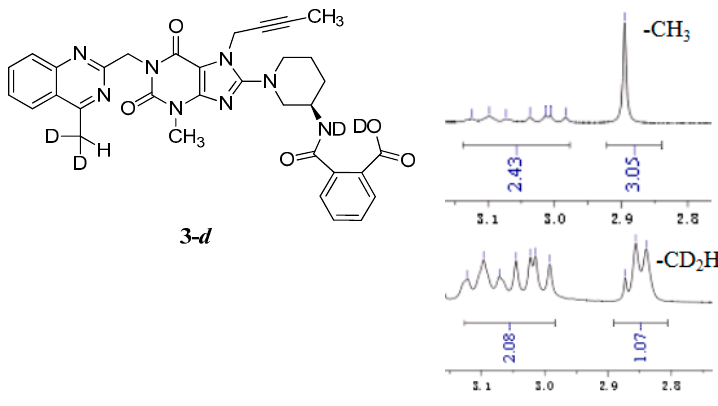
Figure 3. Structures and partial 1 H-NMR spectrum of 3- d .